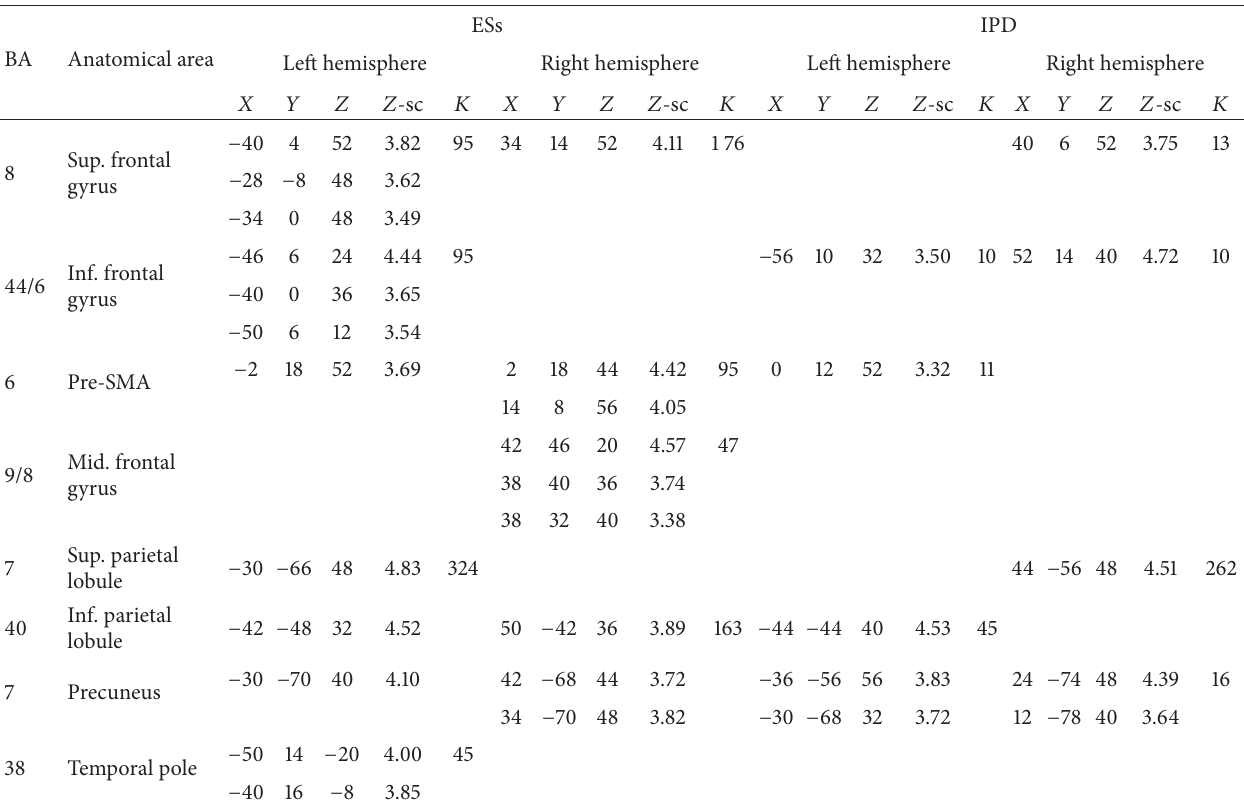
Table 4: Within-groups comparisons in OWMT